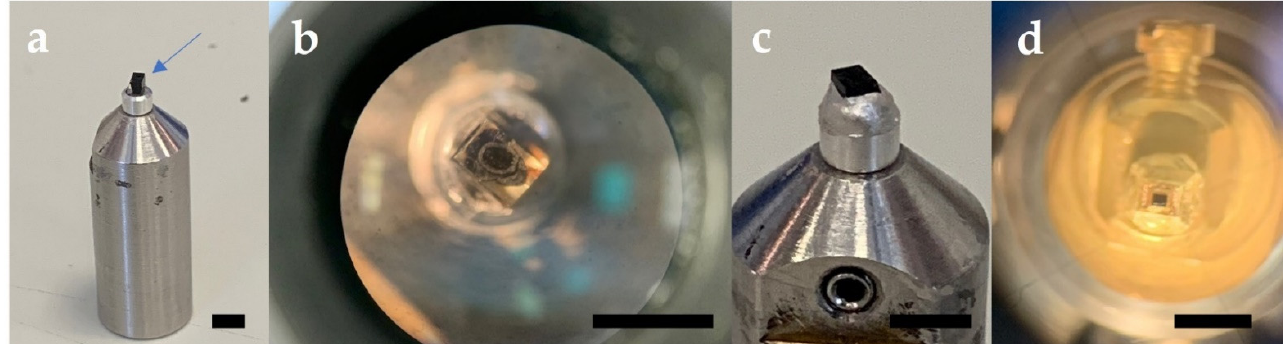
Figure 1. Pin preparation sequence ( a ) trimmed block containing specimen superglued to Gatan pin (blue arrow), ( b ) polished block face, ( c ) epoxy conductive glue applied around edges of block. ( d ) Specimen trimmed for cutting and gold coated. Scale bar black line 2.4 mm.